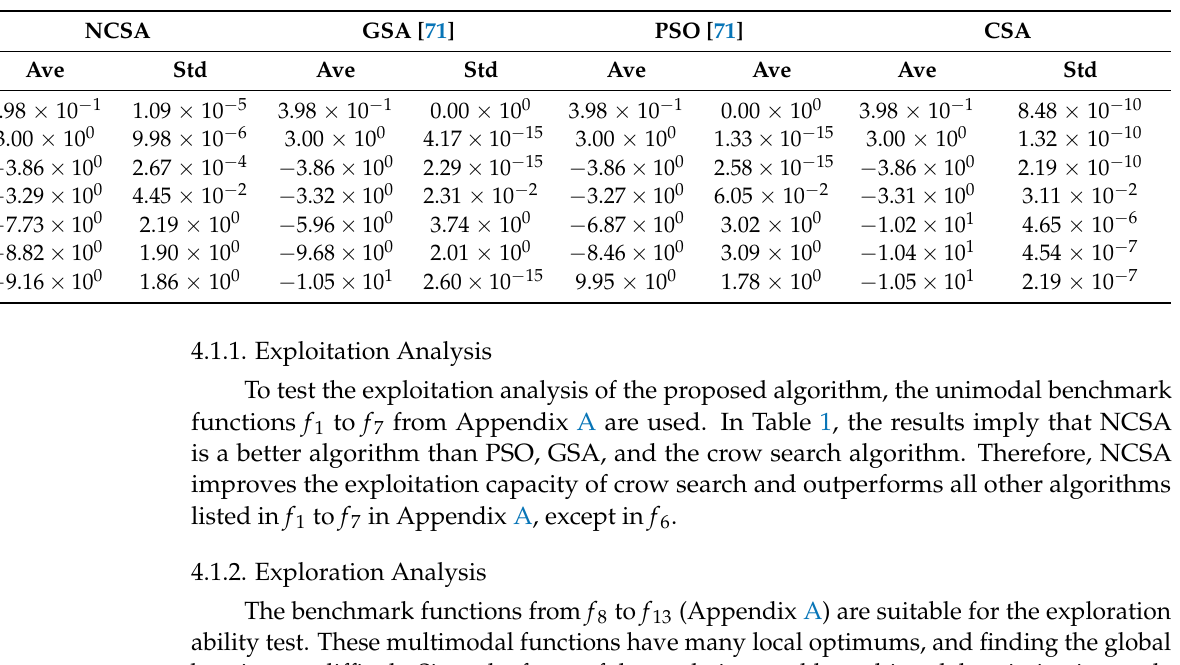
Table 3. Results for fixed-dimensional multimodal benchmark